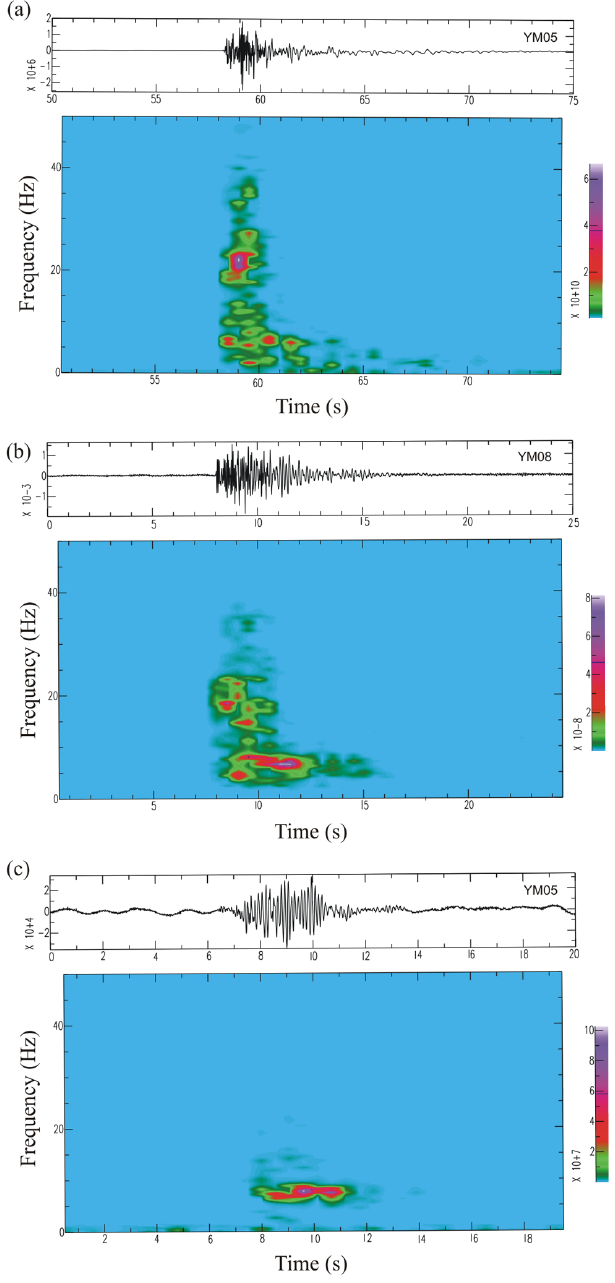
Fig. 2. Vertical velocity waveforms and corresponding spec- trograms for (a) high frequency (HF) event that occurred in 24 April 2006 with M L = 3.1 as recorded in station YM05 (b) mixed frequency event recorded in station YM08 (c) low fre- quency (LF) event recorded in station YM05 (Event #3 in Table